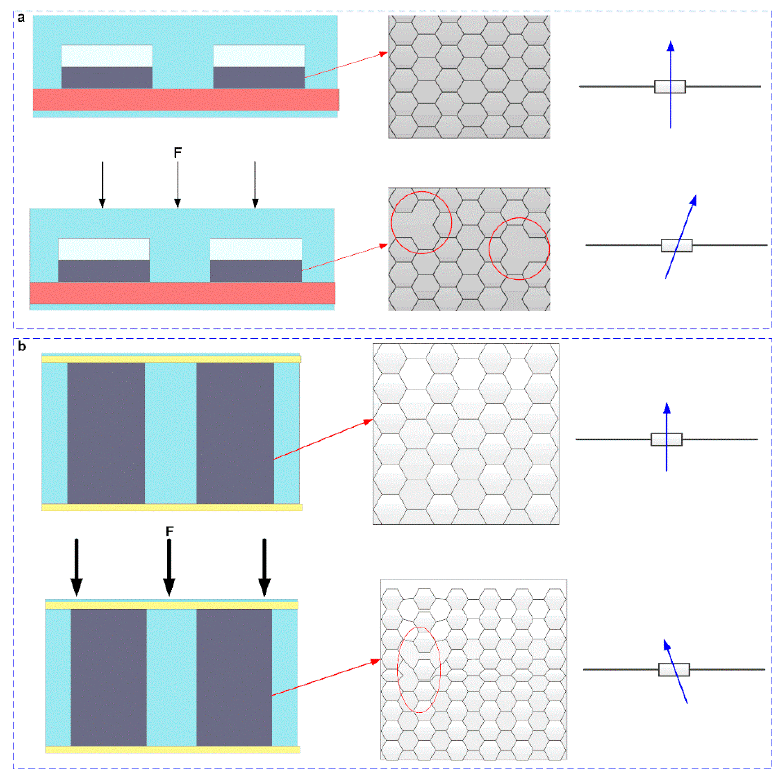
Figure 10. The working mechanism of the tactile-pressure sensor. ( a ) The working mechanism of the tactile sensor. ( b ) The working mechanism of the pressure sensor.